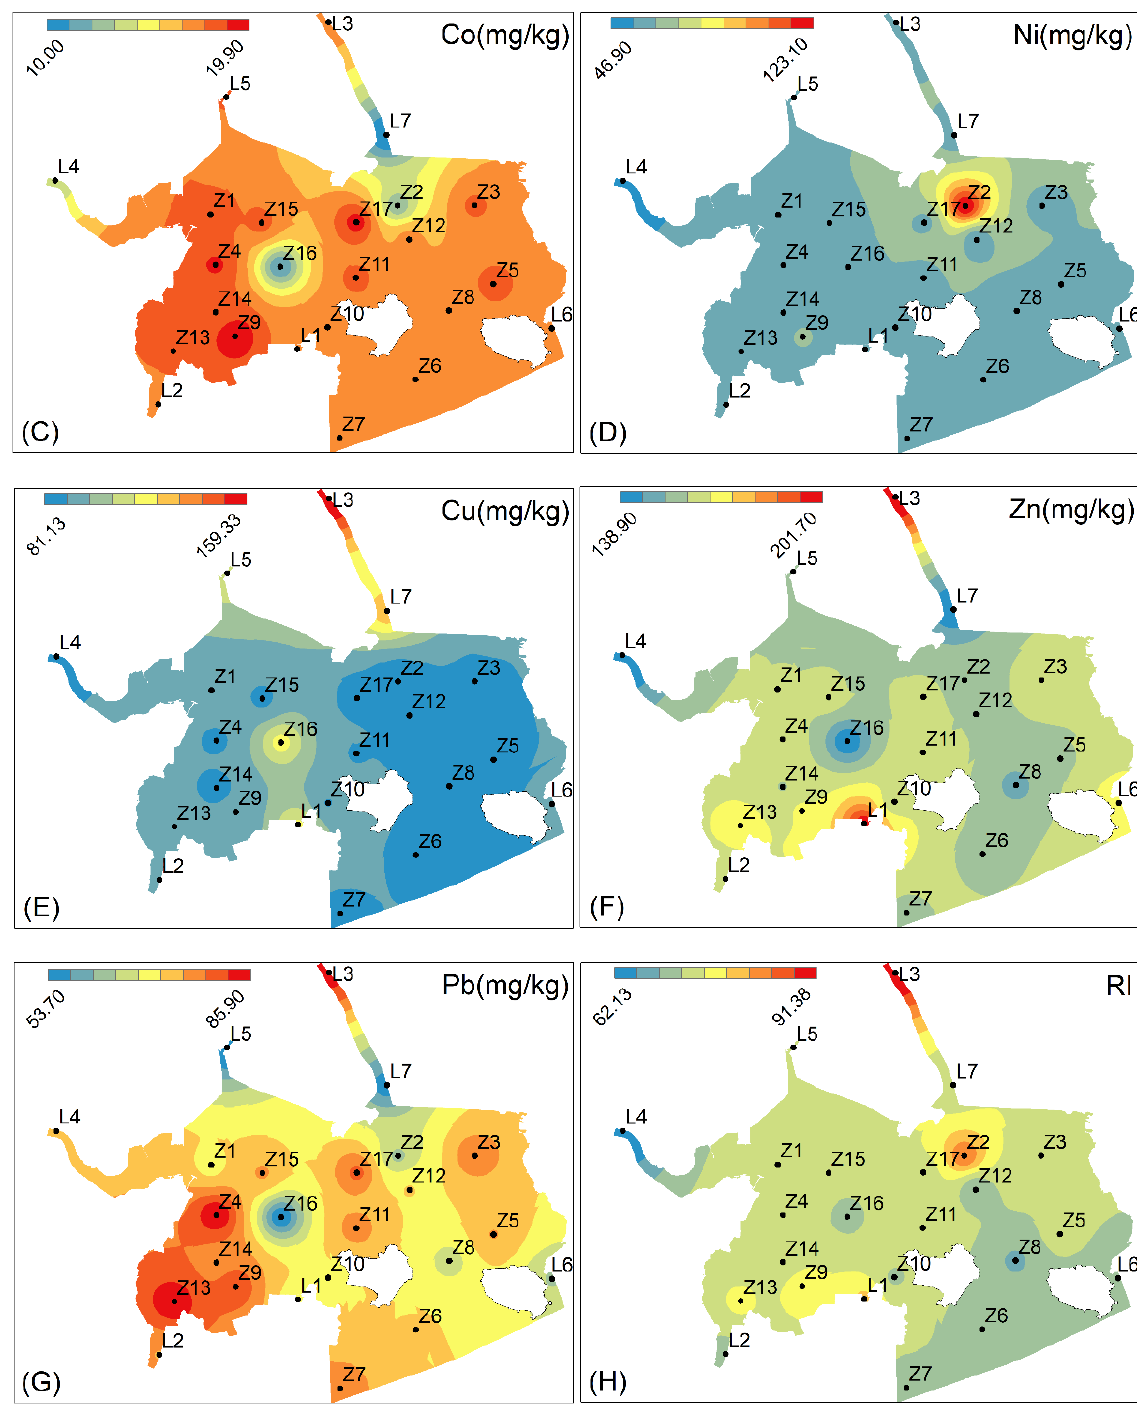
Figure 2. Spatial distribution of Cr, Mn, Co, Ni, Cu, Zn, and Pb ( A – G ) and potential ecological risk index (RI) in surface sediments of the Zhelin Bay ( H ).